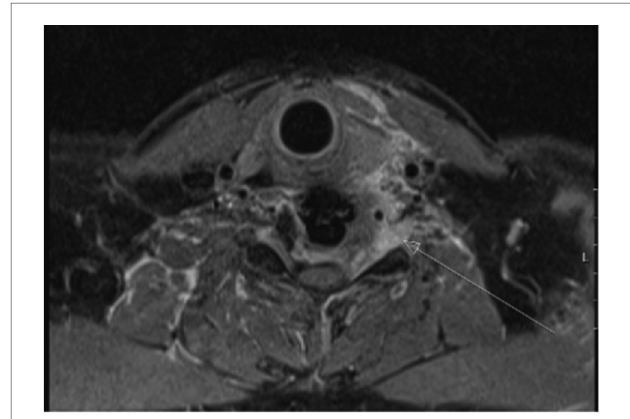
FIGURE 2 Postoperative axial T1-gadolinium MRI showing partial removal of tumor